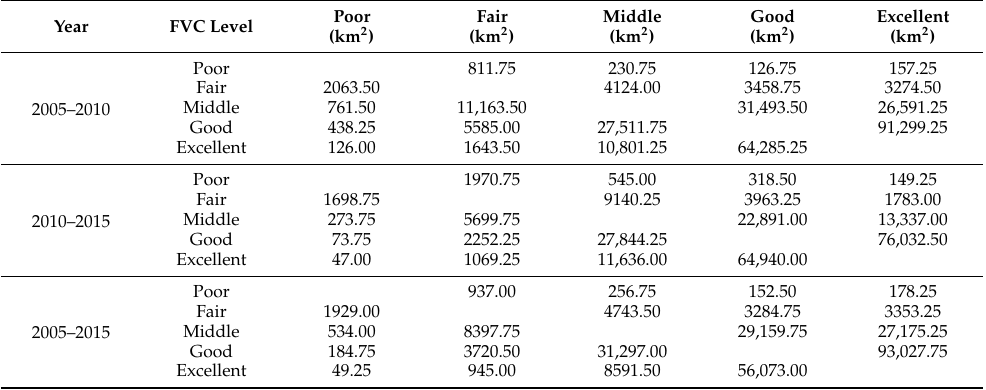
Figure 8. Sankey diagram of area transfer matrix of different FVC levels in the NFB from 2005 – 2015. Table 8. Area transfer matrix of different FVC levels in the NFB from